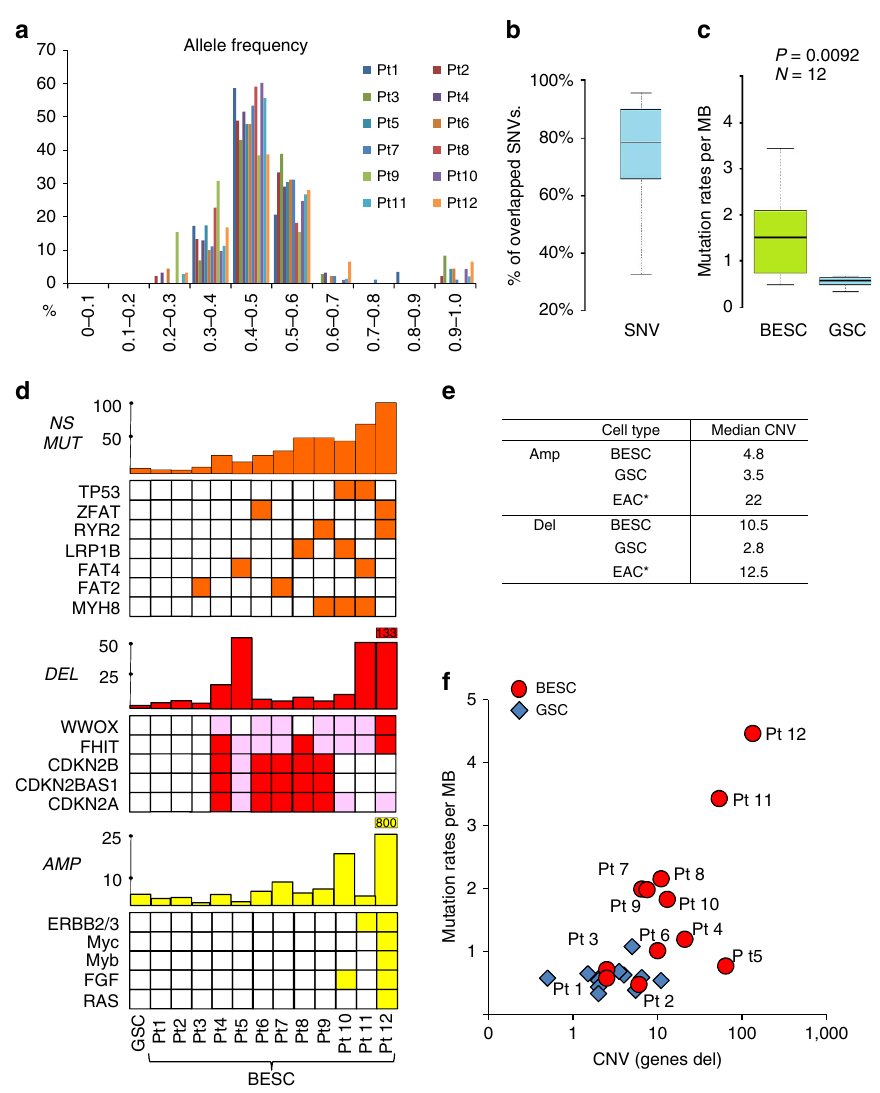
Figure 5 | SNV in Barrett’s stem cell pedigrees. ( a ) Histogram of somatic SNV allele frequency determined from exome sequencing of Barrett’s stem cell pedigrees across the patient study group. ( b ) Distribution and median per cent overlap among SNVs determined from two independent BESC pedigrees (see Methods section). ( c ) Comparison of distribution of somatic mutation rates between BESC and GSC across the patient study group (see Methods section). ( d ) Summary of non-synonymous mutations (NS MUT), interstitial deletions (DEL) and interstitial amplifications (AMP) in Barrett’s stem cells cloned from 12 cases without evidence of high-grade dysplasia. Histograms depict total number of events, whereas specific genes were listed beneath each histogram to highlight genes frequently altered in oesophageal and gastric adenocarcinoma 28,29,37 . ( e ) List of average number of CNV events as amplifications (Amp) or deletions (Del) in Barrett’s and gastric stem cells as well as EAC 34 . ( f ) Graph depicting the distribution of BESC and GSC by mutation rate (SNV per Mb) and CNV (interstitial deletions) 50,51